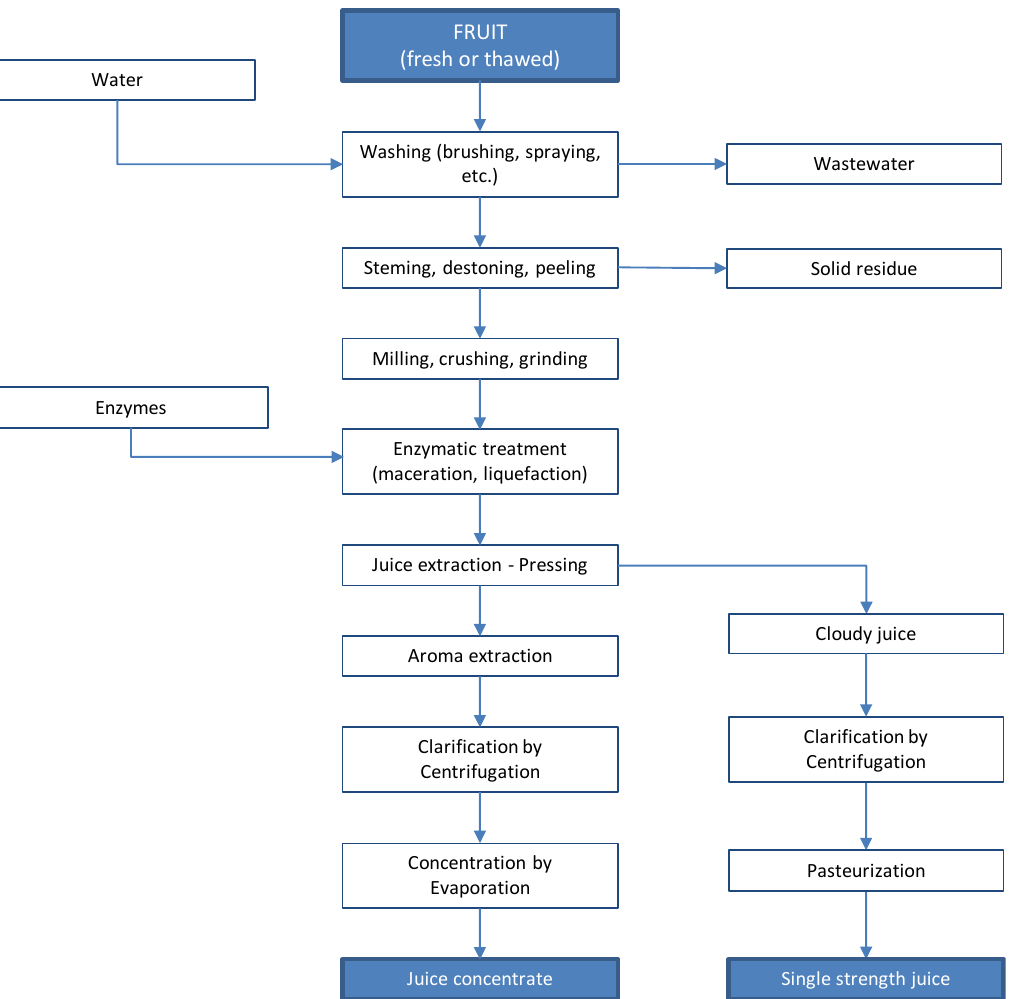
Figure 1. Scheme of conventional fruit juice processing.